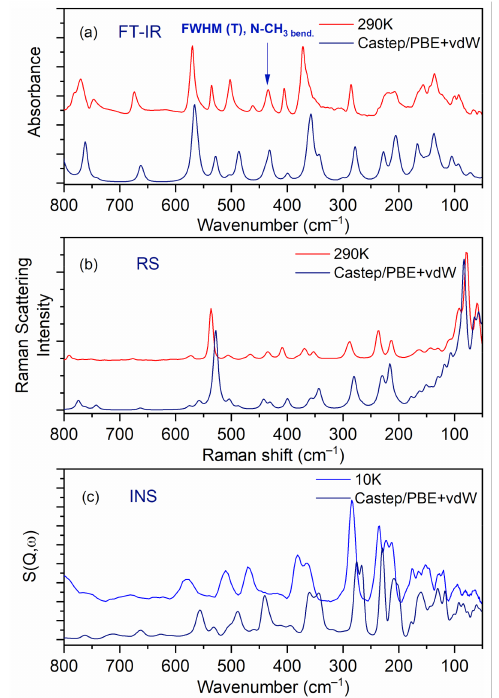
Figure 7. Comparison of experimental and calculated (at PBE + vdW level): ( a ) IR, ( b ) RS, and ( c ) INS spectra for the N,N-dimethylglycine–chloranilic acid complex in the region of 800–50 cm − 1